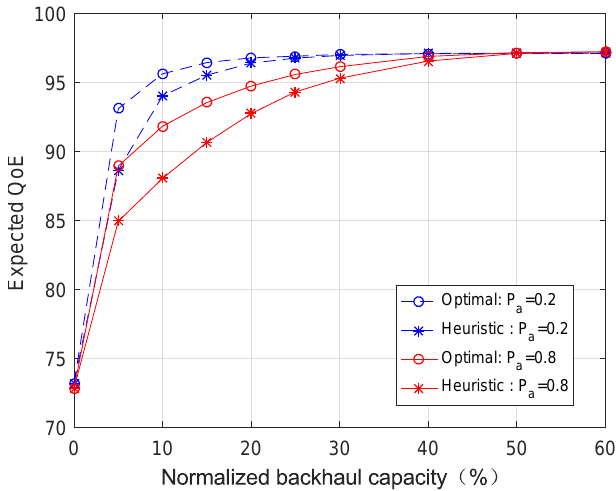
Figure 10. The expected QoE as a function of the normalized backhaul capacity in the multiple time slot optimization problem ( S = 200 MB, I =